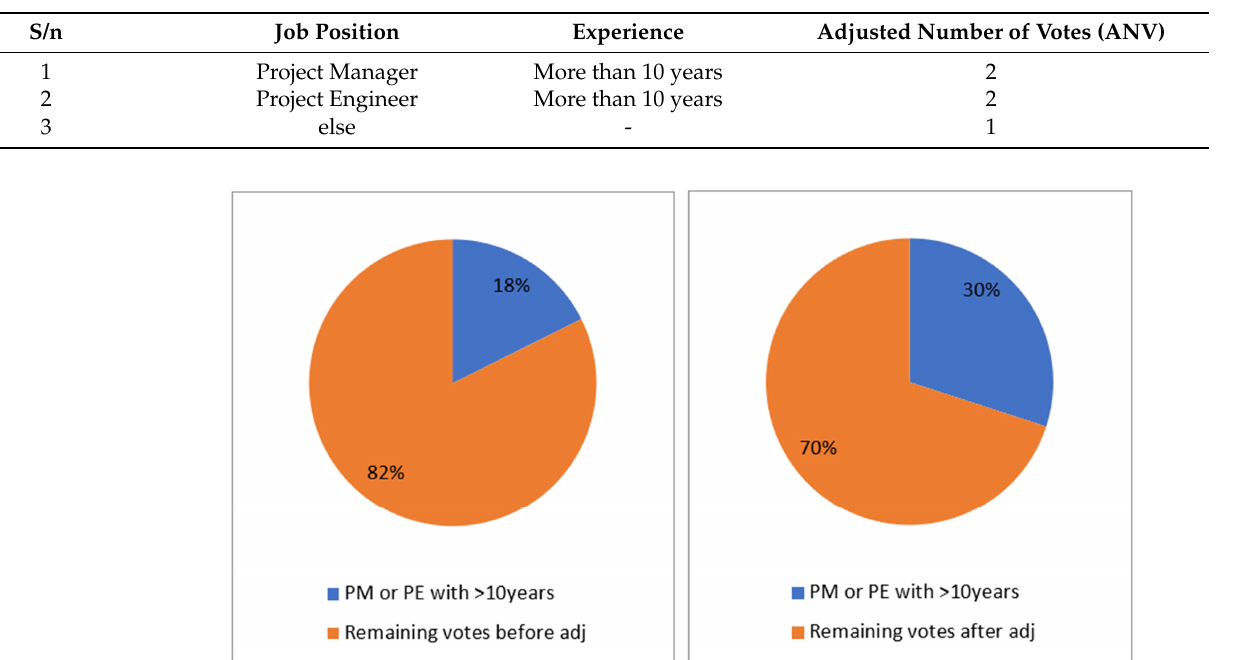
Figure 2. Vote distribution of preferred respondents.